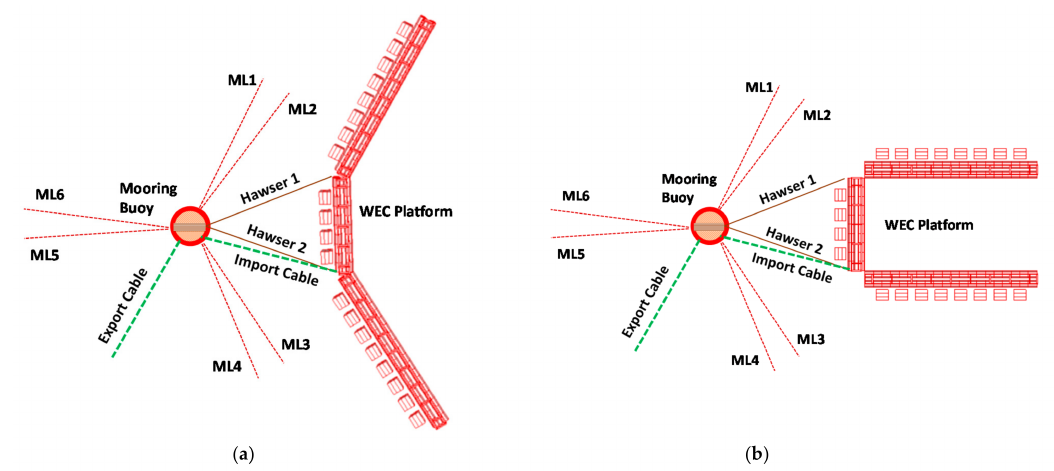
Figure 3. Arrayed WEC platform configurations: ( a ) power production configuration with a side hull section angle of 150 deg. during the operating sea states; ( b ) storm sea configuration with a side hull section angle of 90